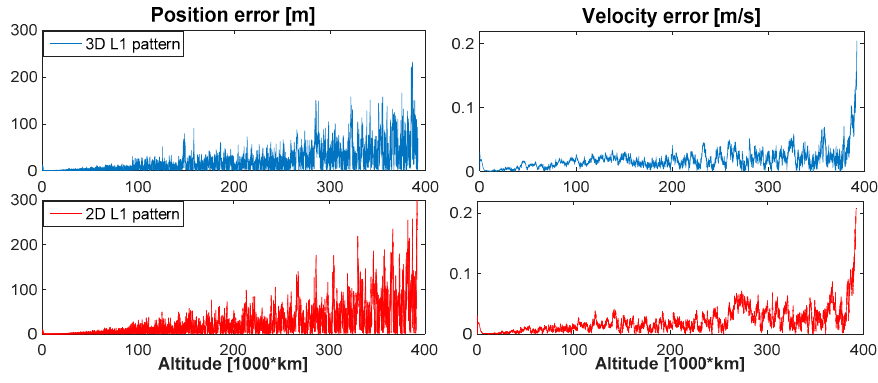
Figure 18. Range-based orbital filter estimation error for the assumed MTO.